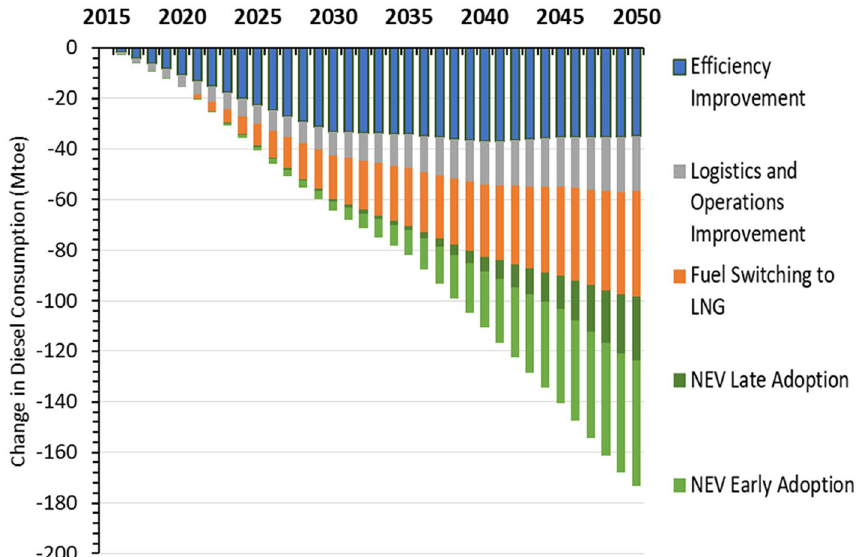
Figure 3. Impact of different decarbonization strategies on heavy-duty trucks’ annual diesel consumption. Change in diesel consumption shown is relative to reference scenario and